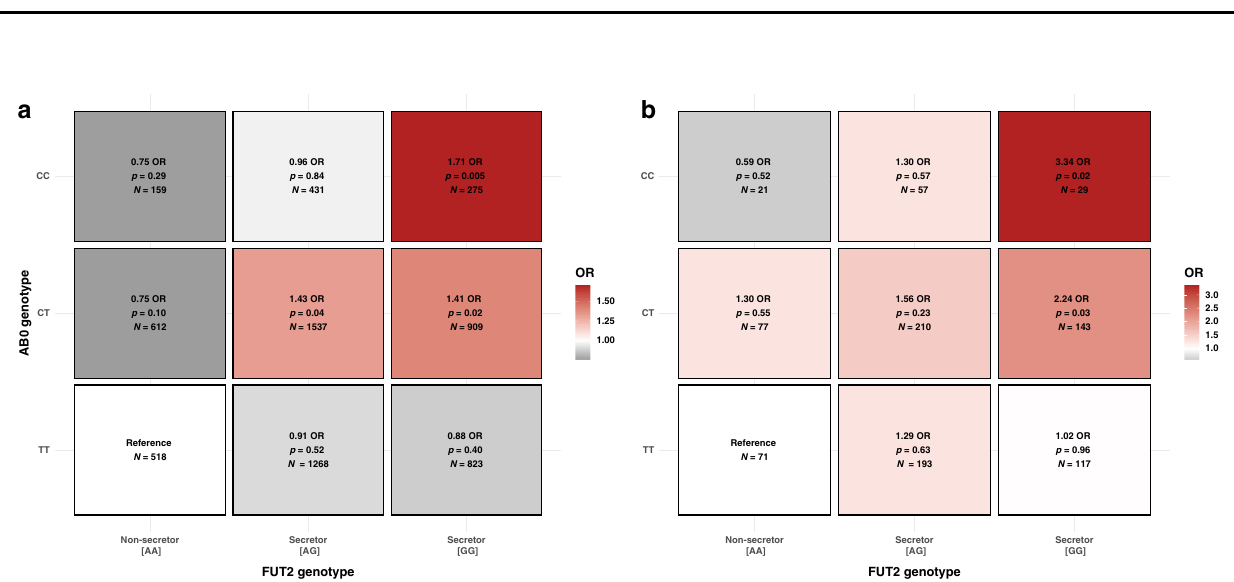
Fig. 2 Association “ heatmaps ” for FUT2 ( rs601338) – ABO (rs505922) genotype combinations. The risk of asthma (OR or odds ratio) was calculated for each genotype combination in relation to the reference group ( FUT2 [AA] and ABO [TT]). Heatmaps are shown for a the COPSAC severe study (discovery) and b the COPSAC birth cohorts (replication). N : number of participants in each group. The logistic regression model in a is adjusted for sex and ten principal components. The model in b is adjusted for sex and cohort